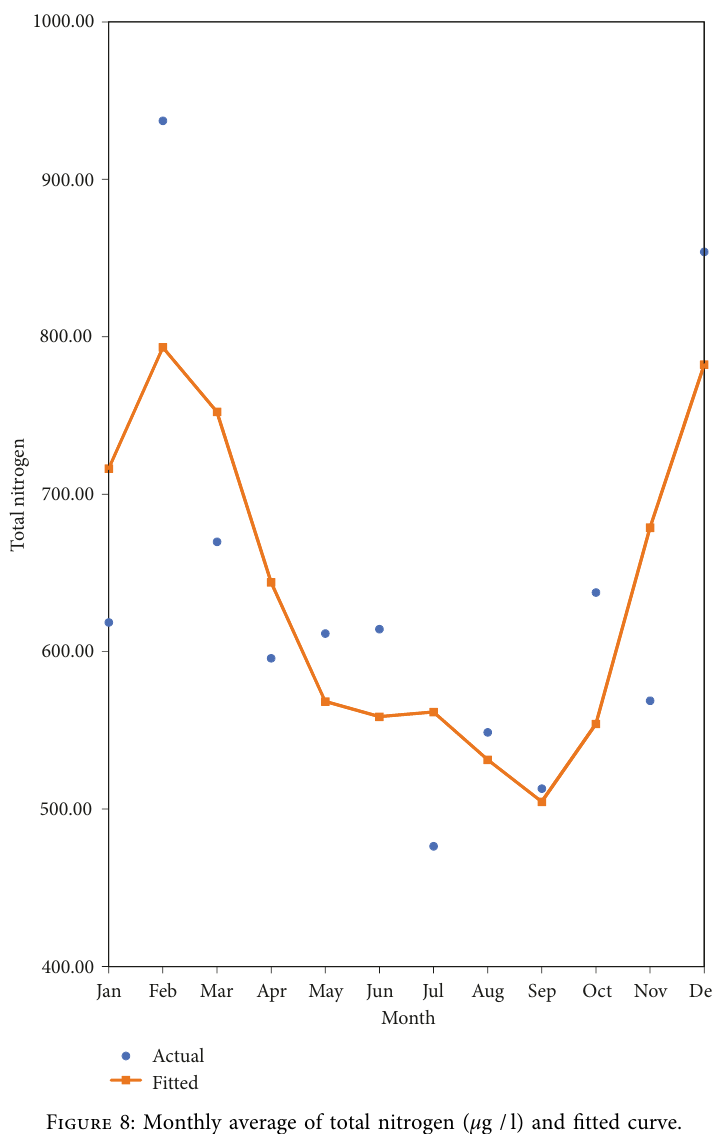
Figure 8: Monthly average of total nitrogen ( μ g / l) and fitted